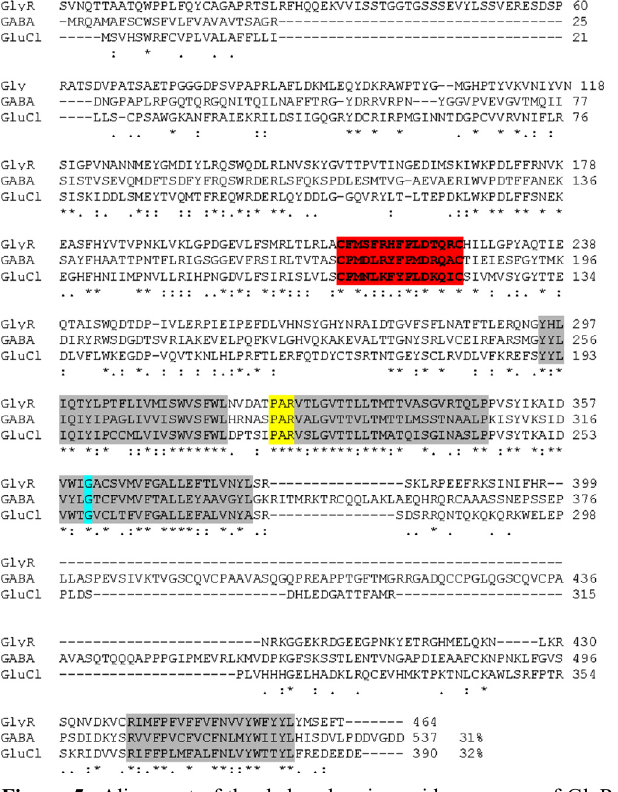
Figure 5. Alignment of the deduced amino acid sequences of GlyR (KJ476181), GluCl (AHE41097) and GABA (AHE41094) receptors from R. microplus . The cysteines forming the Cys-loop are highlighted by red shading; the putative transmembrane domains (TM1–TM4) are shaded ingray. The PARresiduesare highlighted inyellow. The glycine residuemarkedinturquoise likely confersupon the receptorssensitivity to